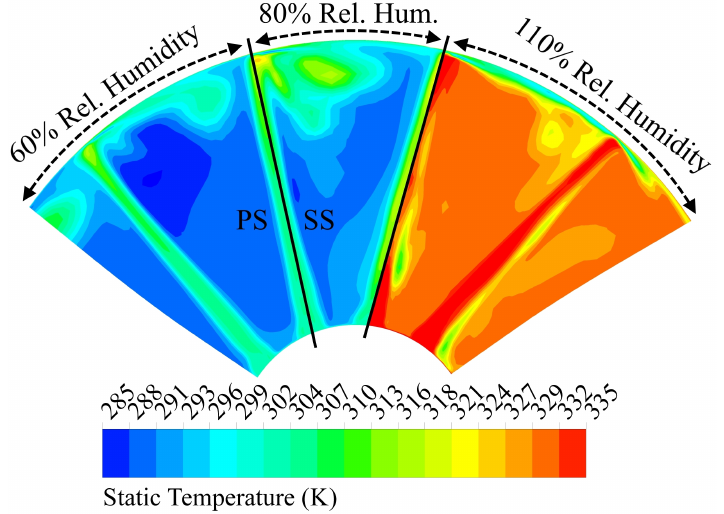
Figure 7. Static temperature at plane P1.